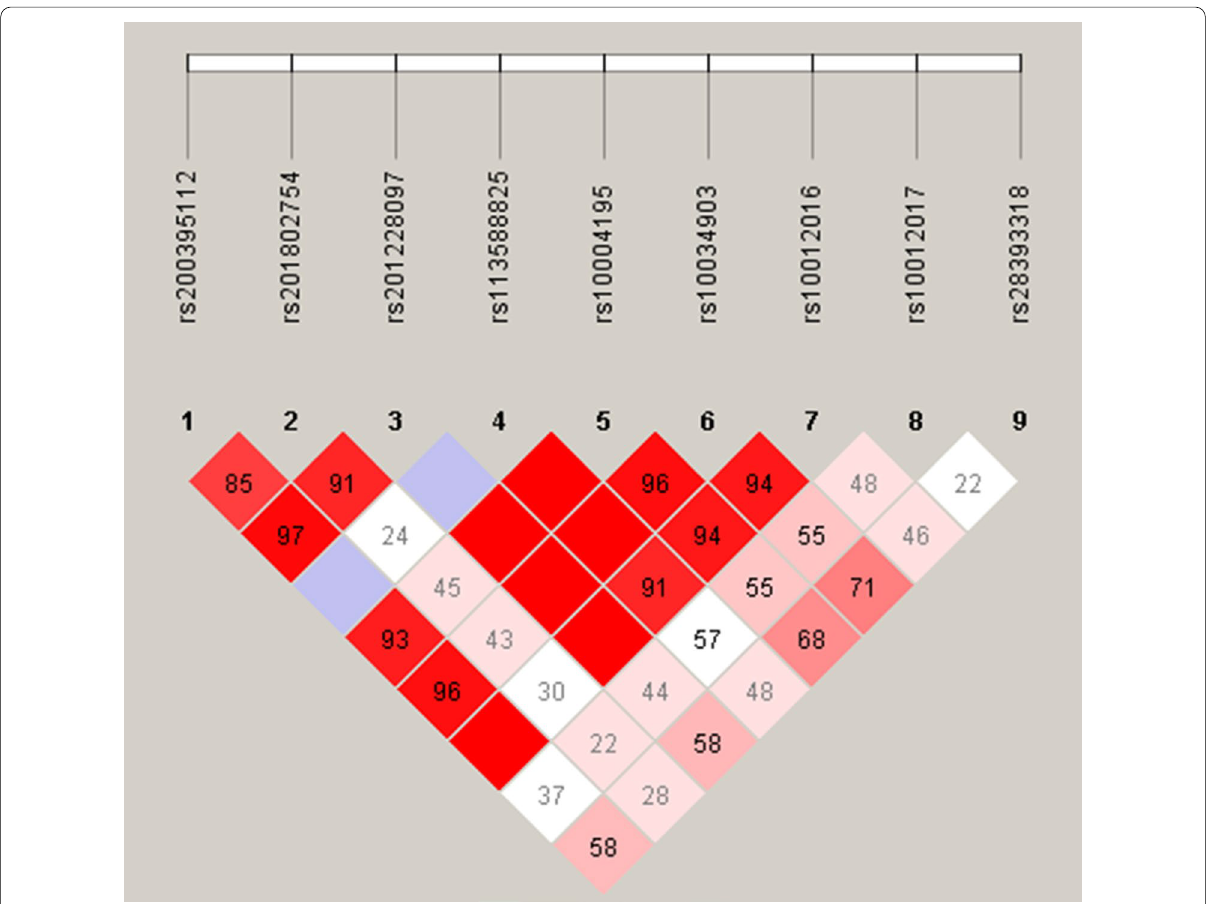
Fig. 2 Linkage disequilibrium (LD) map of nine SNPs within the TLR10 gene. LD blocks were generated using the default algorithm in Haploview software (version 4.2). The coloring of the boxes is based on the scores of two estimates, logarithm of odds (LOD) and LD coefficient (D ʹ ). Strong LD (LOD > 2 and D ʹ 1) is indicated in red. A decrease in the intensity of red indicates lower LOD and D ʹ values. Regions with weak LD (LOD > 2 and = 0.21 < D ʹ < 1) are shown in blue. Regions with no LD (LOD < 2 and D ʹ < 1) are shown in white. The number within each box indicates the D ʹ statistic value multiplied by